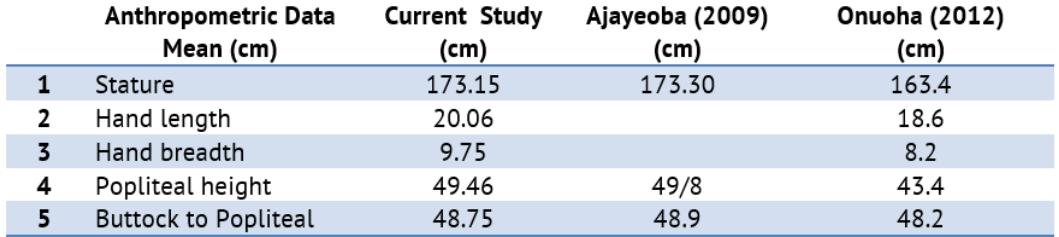
Comparison of drivers’ anthropometric (Mean) dimensions of the current study and previous related